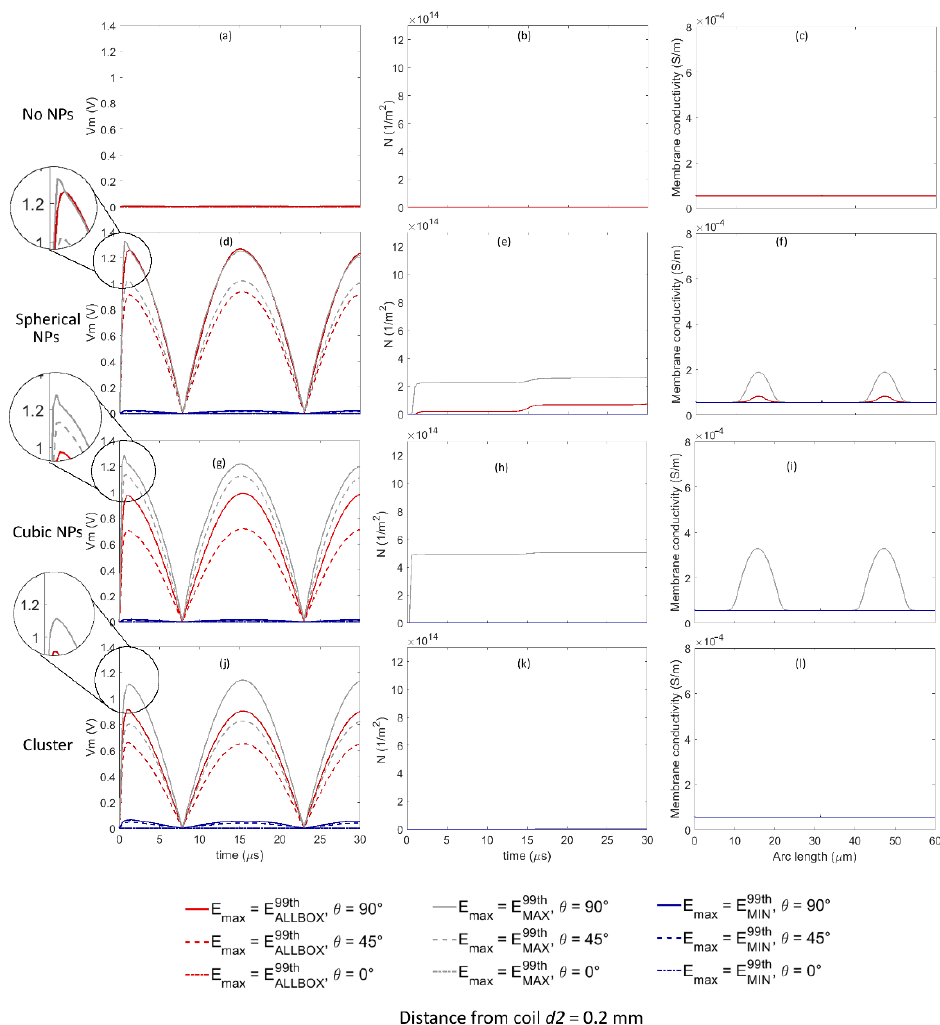
Figure 5. Time evolution of the transmembrane voltage V m (first column, ( a , d , g , j )), pore density N (second column, ( b , e , h , k )), and the variation in the conductivity along the cell membrane for t equal to 15 µ s (third column, ( c , f , i , l )) at distance d 2 from the coil, when the amplitude of the external applied electric field was equal to E 99th AllBox , E 99th MAX , and E 99th MIN , when no Au NP was considered (first row, ( a – c )), and for the spherical, cubic, and cluster Au NP configurations (second row, ( d – f ), third row, ( g – i ), and fourth row, ( j – l ), respectively).